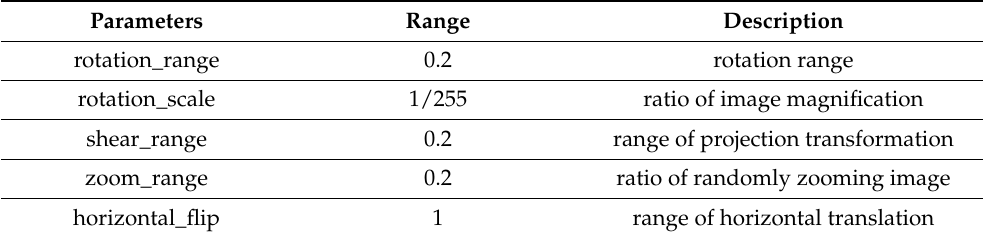
Table 2. Parameters setting of data